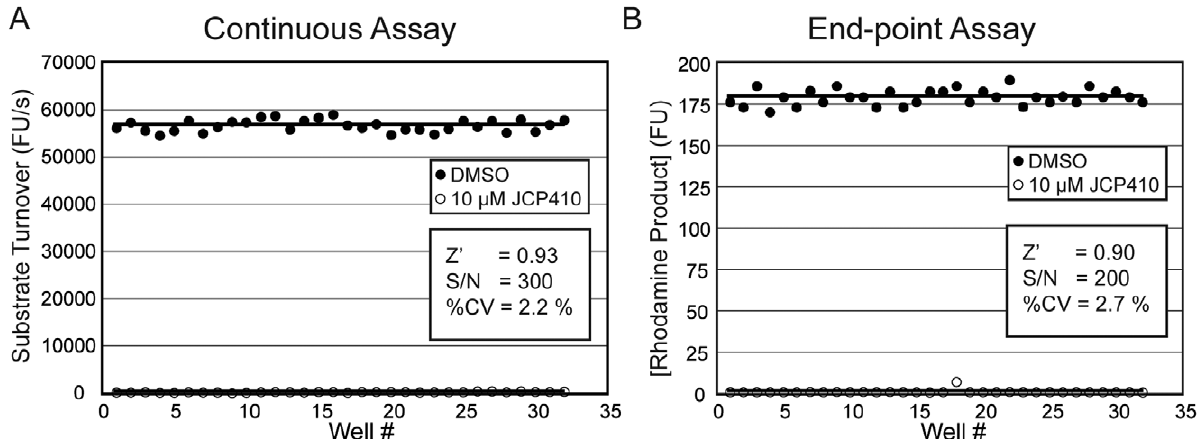
Figure 2. Development of a DPAP1-specific HTS assay. A. Continuous assay. The assay was carried out in 384-well plates using 1% of parasite lysates. Substrate turnover was continuously measured for 5 min. JCP410 (10 m M) was used as a positive inhibition control. Z’ factor, S/N, and % CV of the negative control are shown. B. End-point assay for HTS. The reaction described in A was quenched after 10 min by addition of 0.5 M acetic acid. The final concentration of rhodamine product was quantified by fluorescence.